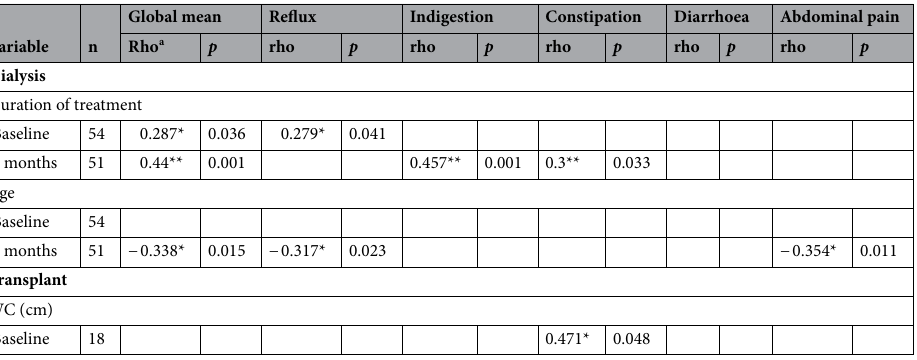
Table 4. Correlations of GSRS scores with clinical and nutritional parameters in transplant candidates and recipients at baseline and at 6 month follow-up. *Correlation is significant at the 0.05 level (2-tailed). **Correlation is significant at the 0.01 level (2-tailed). a Spearman’s correlation